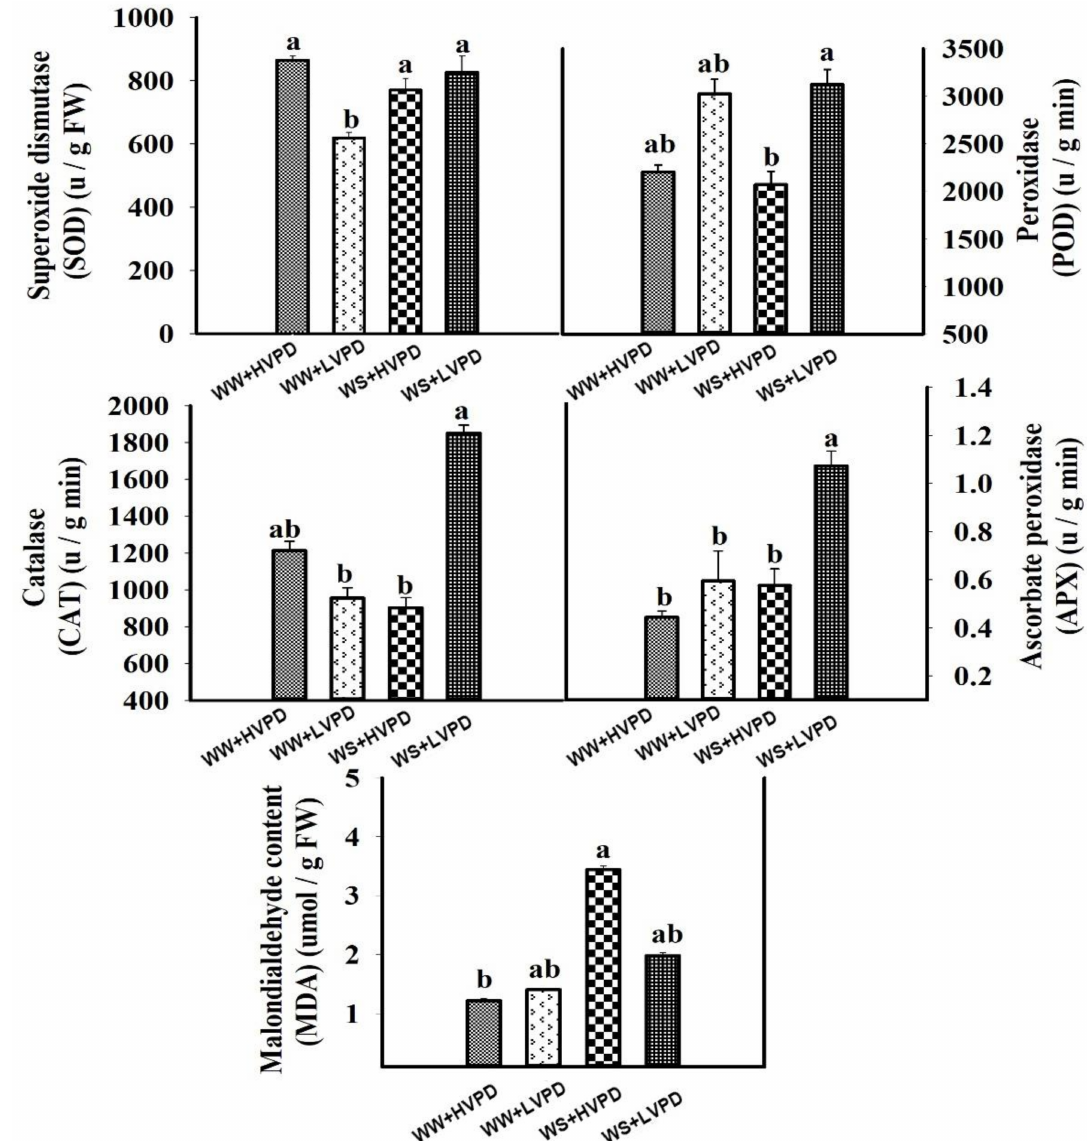
Figure 8. Effects of VPD and soil moisture content on the SOD, POD, CAT, and APX activities and MDA contents in tomato. Data represent means ± standard error ( n = 10). Letters represent significant differences between treatments. Different letters indicate significant differences ( p < 0.05). WW